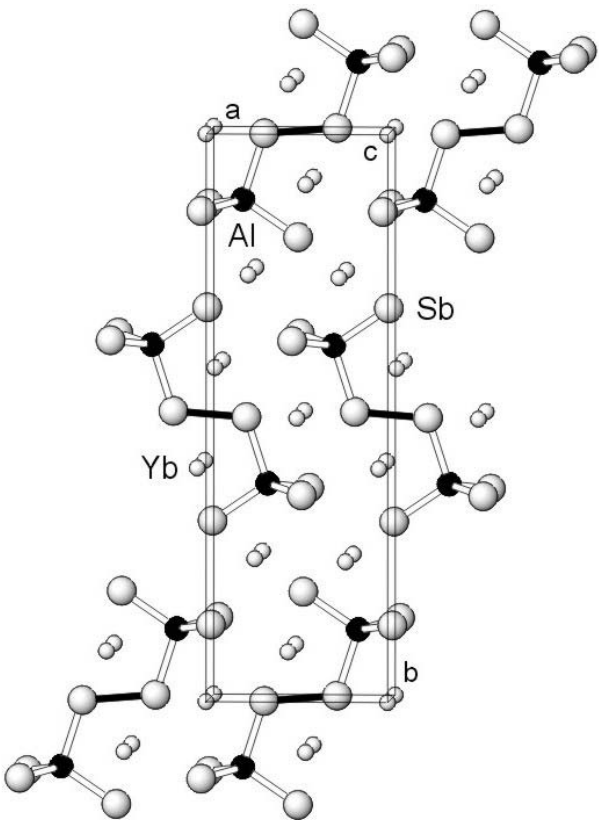
Table 1. Data collection and handling.